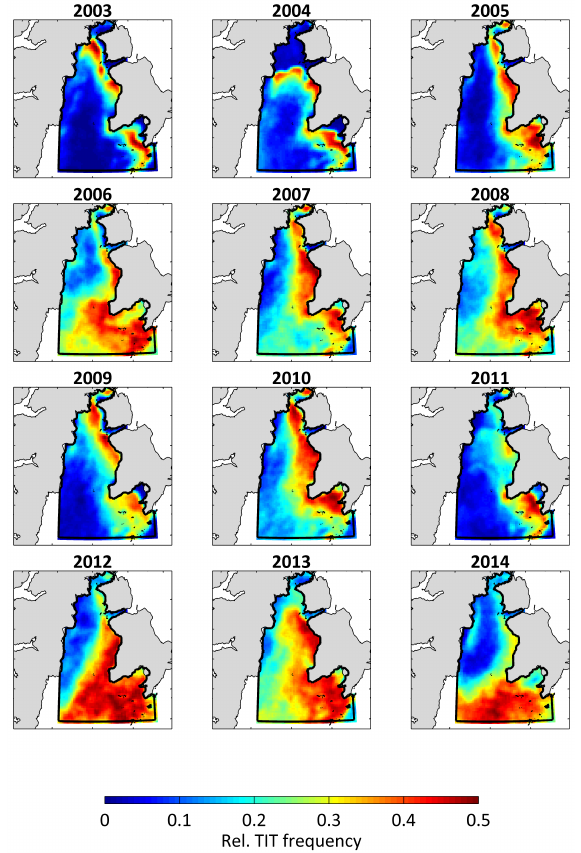
Figure 6. Late freezing season (January to March) relative fre- quency distribution of thin-ice thicknesses ≤ 0.2m for 2003 to 2014, based on daily TIT composites.